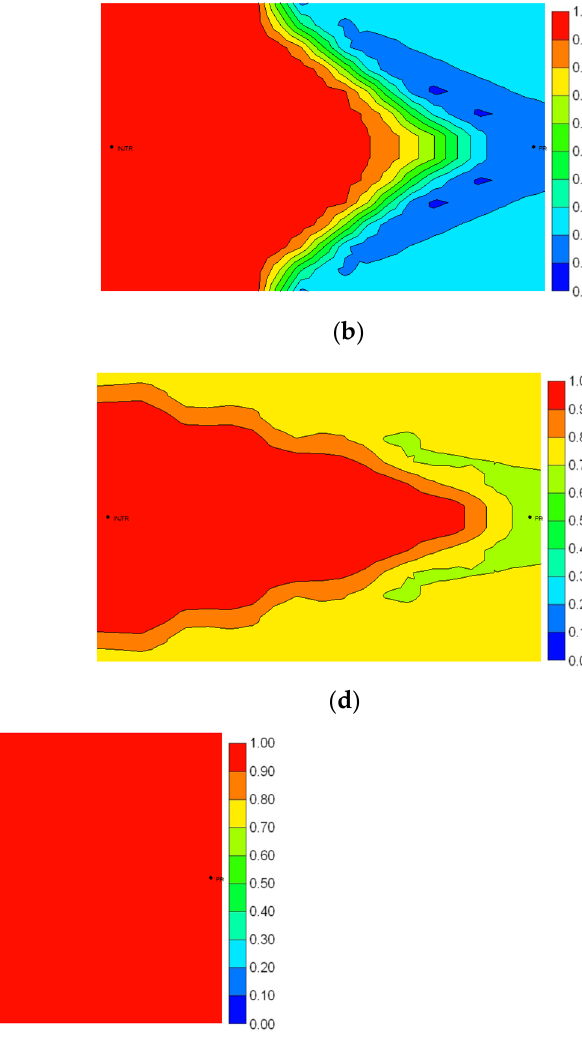
Figure 10. Oil saturation distribution after steam flooding. ( a ) mass fraction of heavy components: 0. ( b ) mass fraction of heavy components: 0.25. ( c ) mass fraction of heavy components: 0.5. ( d ) mass fraction of heavy components: 0.75. ( e ) mass fraction of heavy components: 1.0.